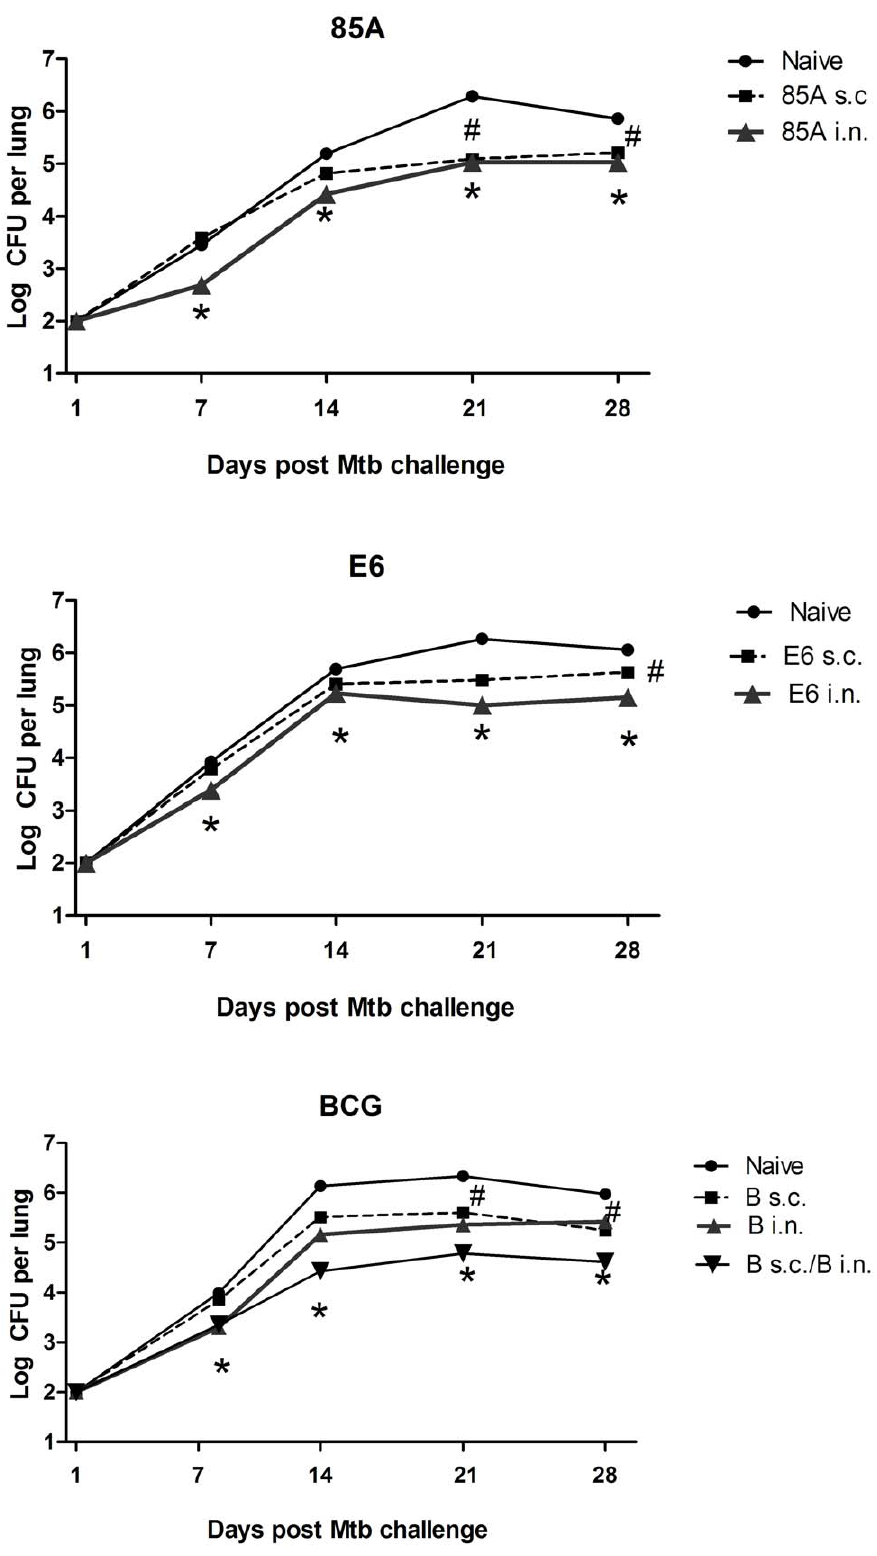
Figure 5. Kinetics of Mtb growth after s.c. and i.n. immunization. C57BL/6 mice were immunized once with BCG s.c., BCG i.n. or BCG s.c./BCG i.n. or 3 times at two weekly intervals with 85A s.c., 85A i.n., E6 s.c. or E6 i.n. Ten weeks after immunization with BCG or 4 weeks after the last immunization with 85A or E6, mice were challenged with Mtb and groups of 3–5 mice sacrificed 7, 14, 21 and 28 days later for enumeration of lung Mtb cfu. # indicates a significant difference between s.c immunized and naı¨ve mice and * a significant difference between i.n. or SIM immunized mice and naı¨ve controls, one-way ANOVA with Tukey’s post test. Data are means 6 s.e.m. Standard errors are small, so that the error bars are within the symbols when not visible. doi:10.1371/journal.pone.0027477.g005 PLoS ONE |